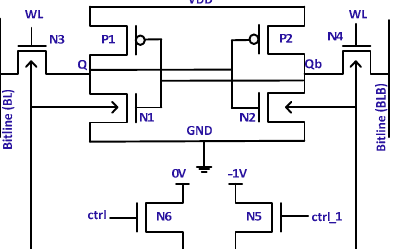
Figure 11. SRAM cell with body biasing control circuit [48].